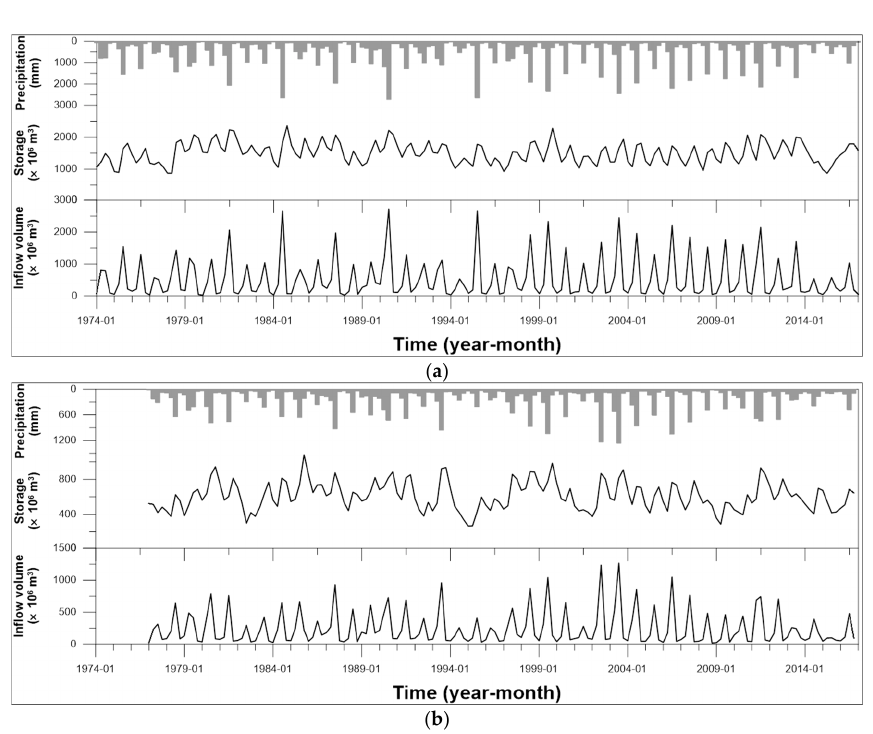
Figure 6. Quarterly operational records of dams: ( a ) Soyanggang dam; ( b ) Andong dam.